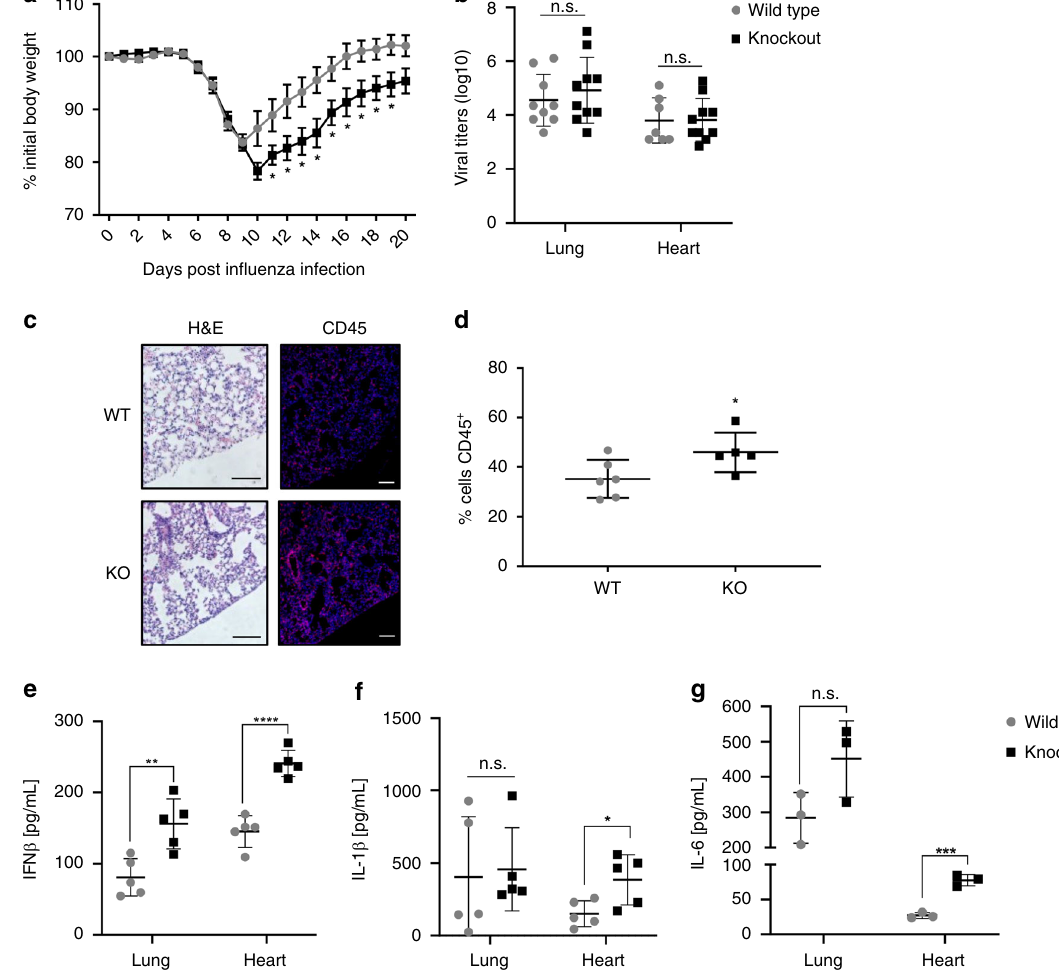
Fig. 3 MG53 knockout mice have worsened morbidity following in fl uenza infection. a Mice were infected intranasally with in fl uenza virus PR8 (10 TCID50). MG53 KO mice lost more weight and took longer to recover following PR8 infection compared to controls ( n = 12 mice/group, mean ± SE; * p